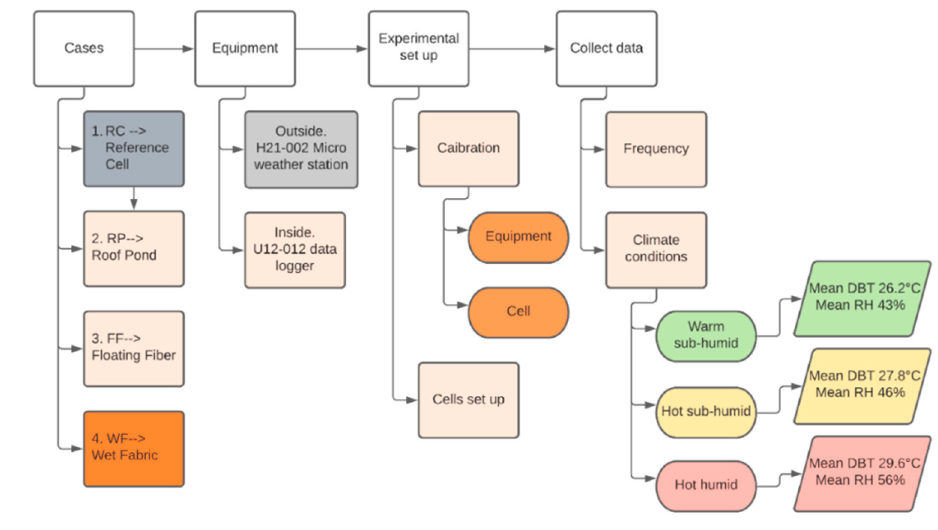
Figure 1. Research process demonstrated by selected variables and methods.